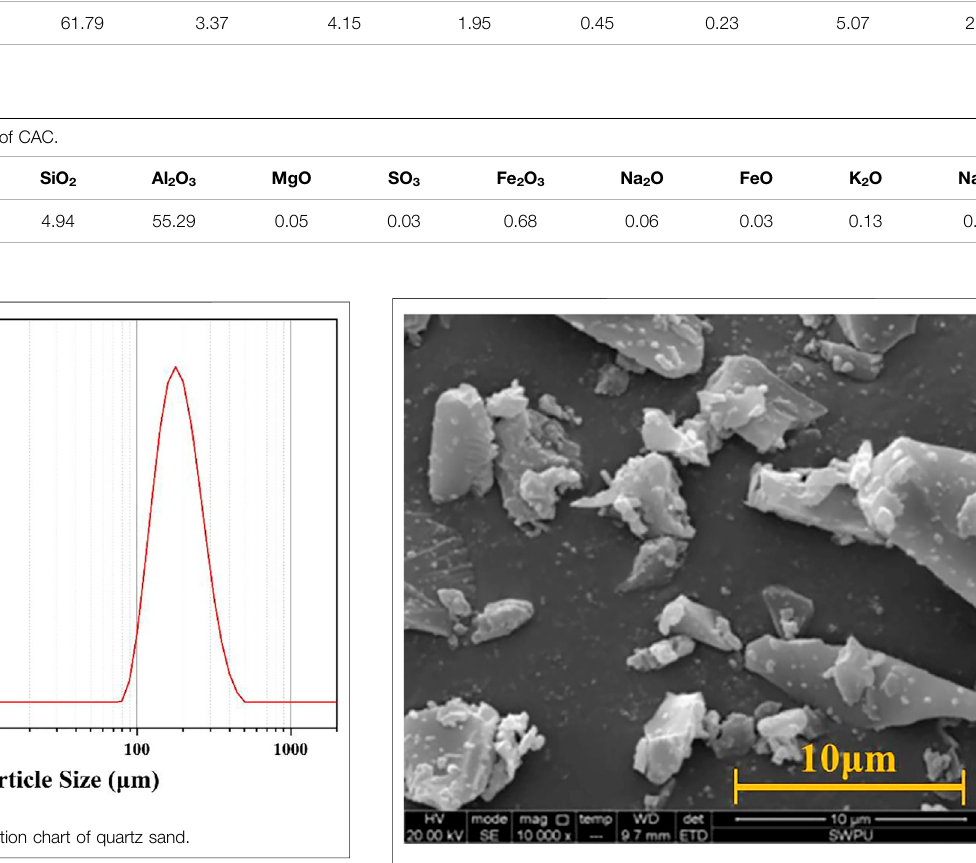
FIGURE 2 | Microstructure of high-temperature